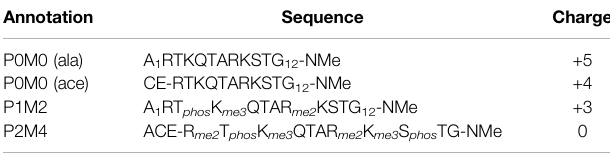
TABLE 1 | Annotation, exact sequence and total charge of the H3